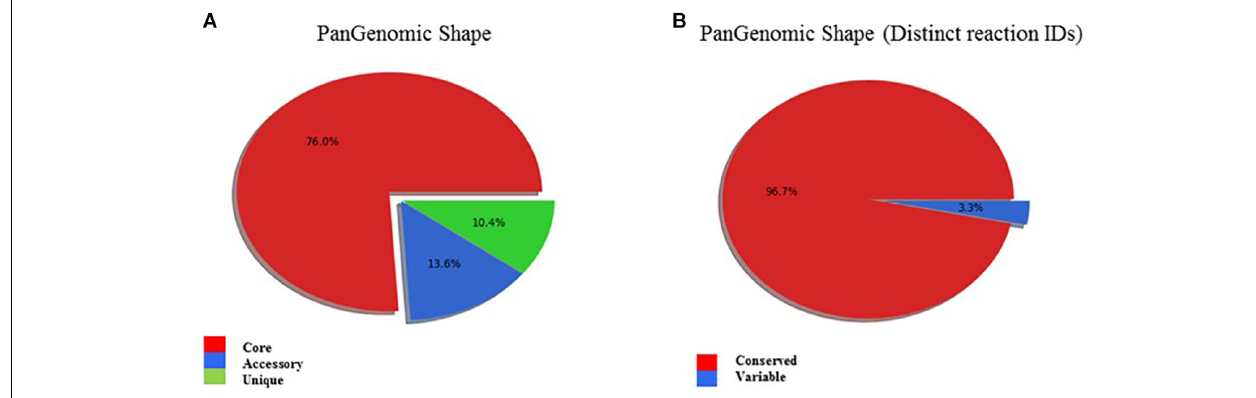
FIGURE 6 | (A) PanGenomic shape showing high genomic conservation amongst outbreak associated L. monocytogenes strains. Genes found in all strains are labeled as “ core ,” and the others as “ dispensable ”: Dispensable genome is divided into “ accessory ,” when a gene is present in at least two strains, and “ unique ,” when a gene is present in exactly one strain. (B) PanGenomic Shape based on distinct reaction IDs demonstrates high metabolic pathway conservation amongst the outbreak associated L. monocytogenes strains.